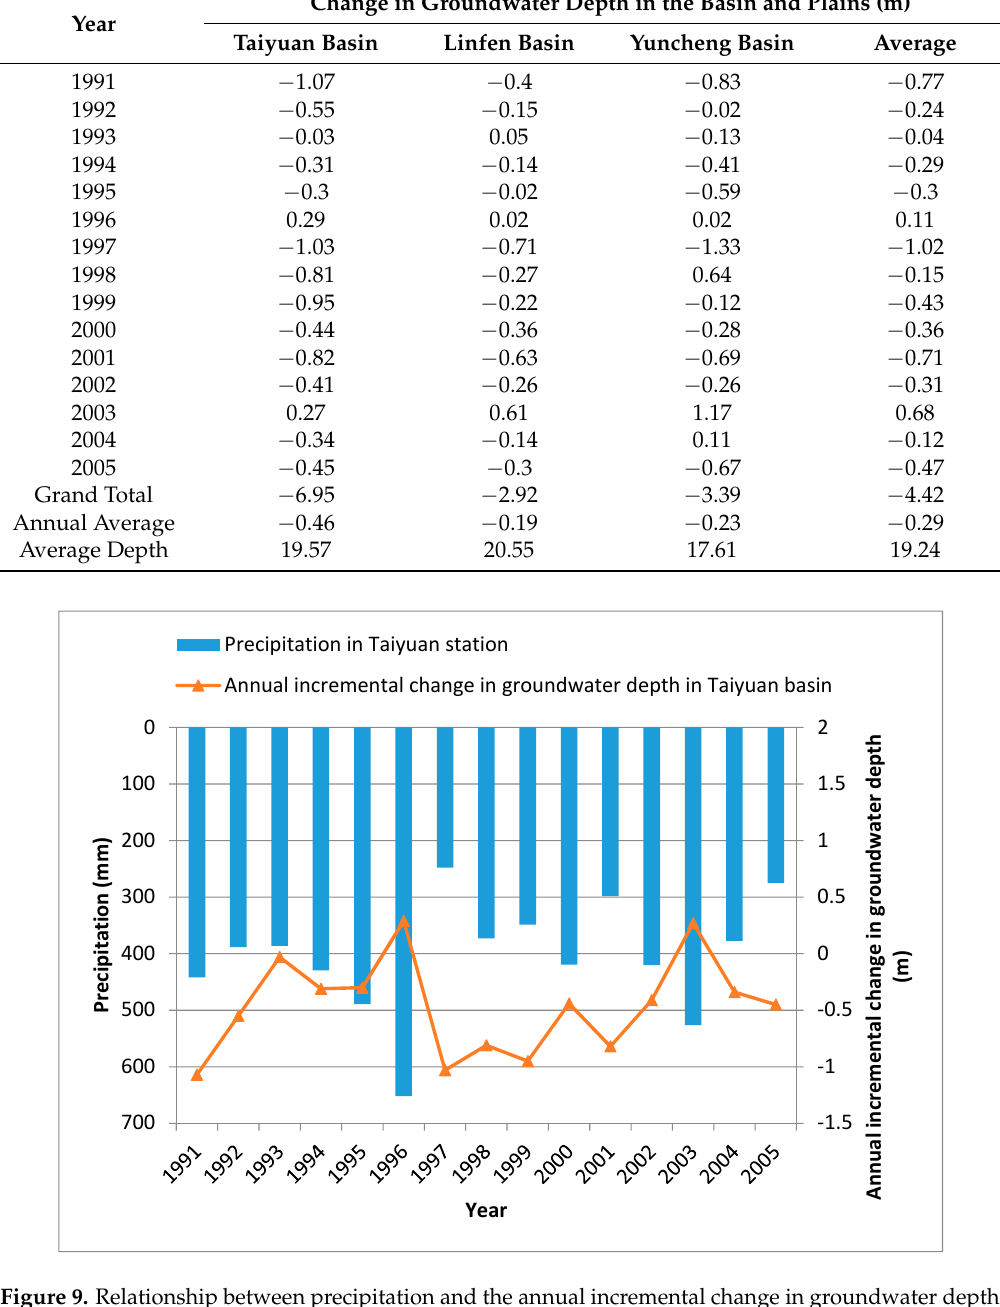
Figure 9. Relationship between precipitation and the annual incremental change in groundwater depth at Taiyuan station in the Fenhe River basin.